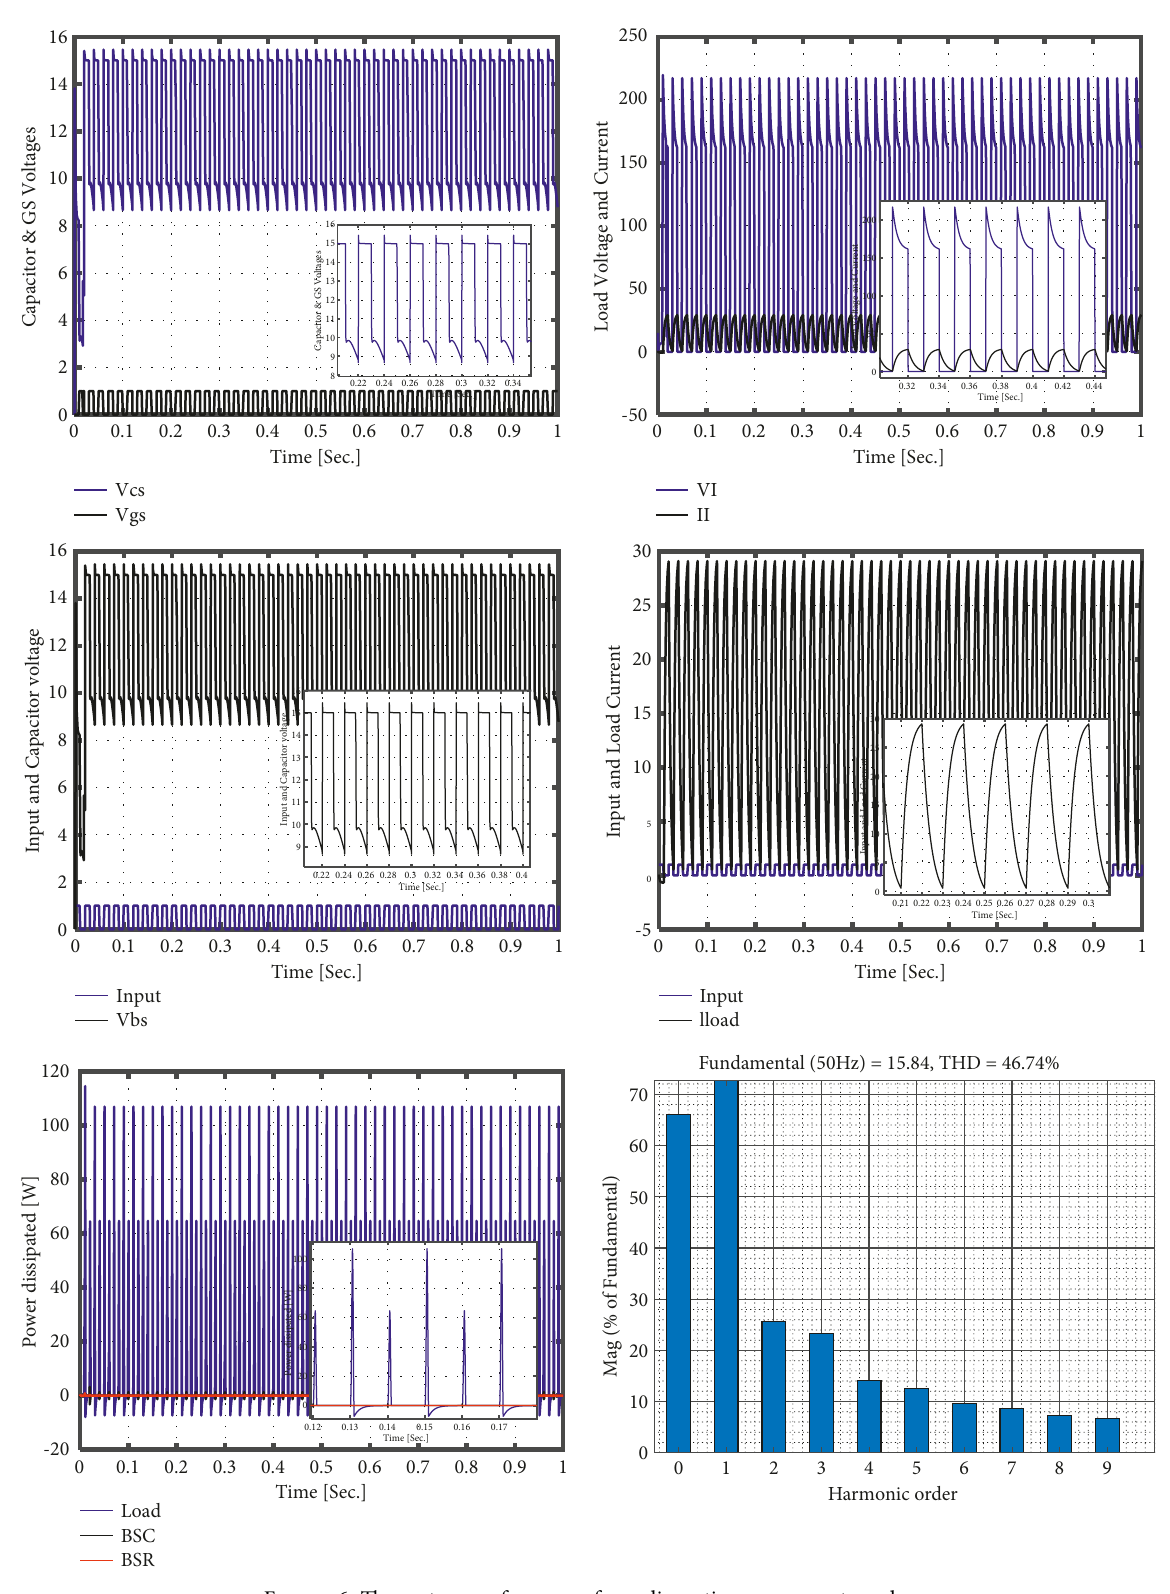
Figure 6: The system performance for a discontinuous current